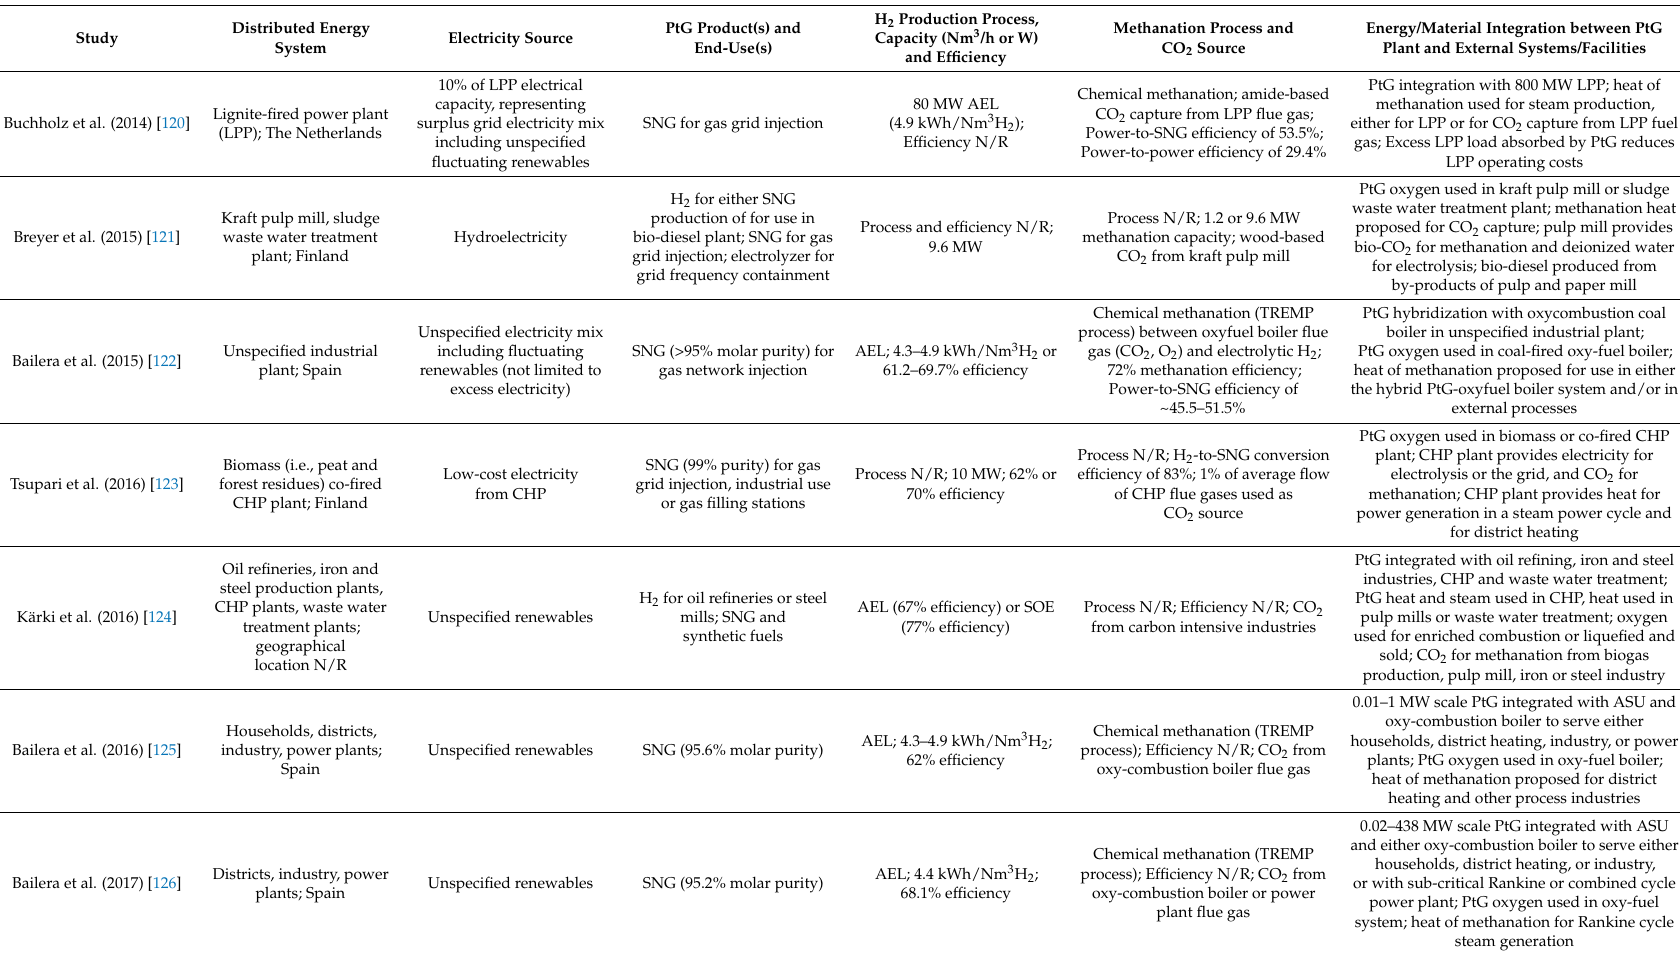
Table 2. Summary of published investigations of distributed-scale PtG deployment